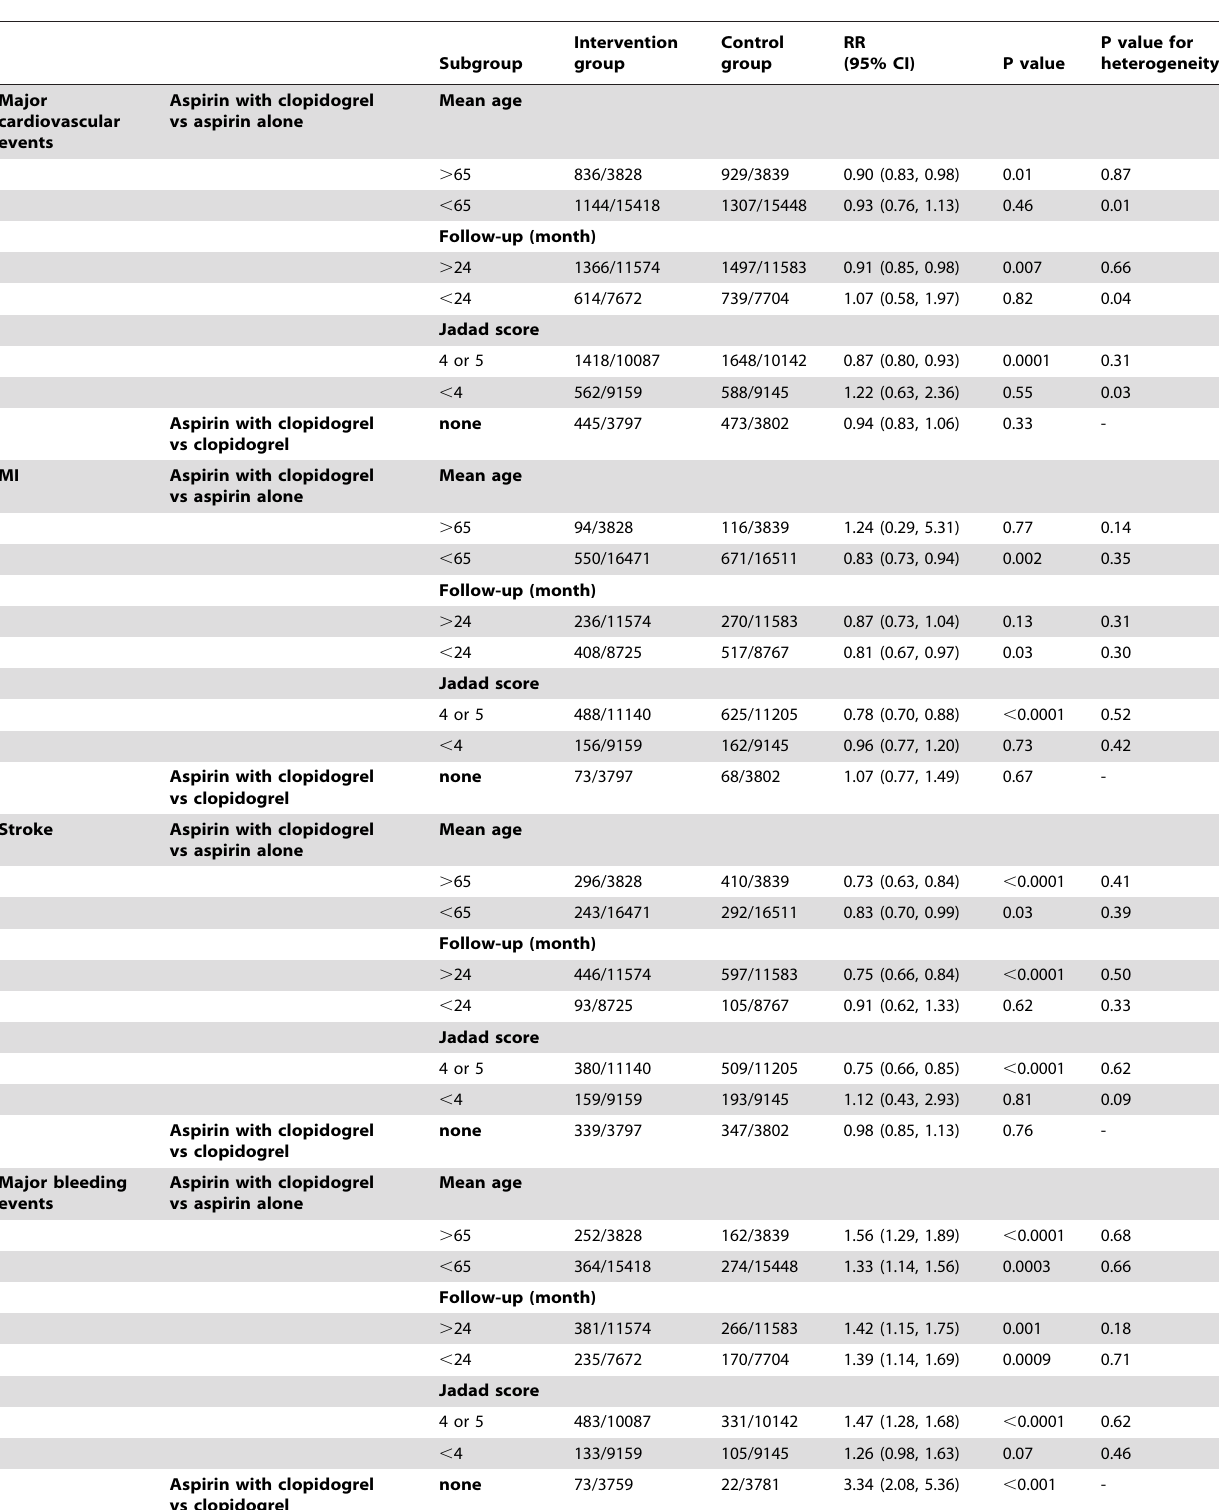
Table 3. Subgroup analysis of major cardiovascular events, myocardial infarction, stroke and major bleeding events after treatment with aspirin and clopidogrel